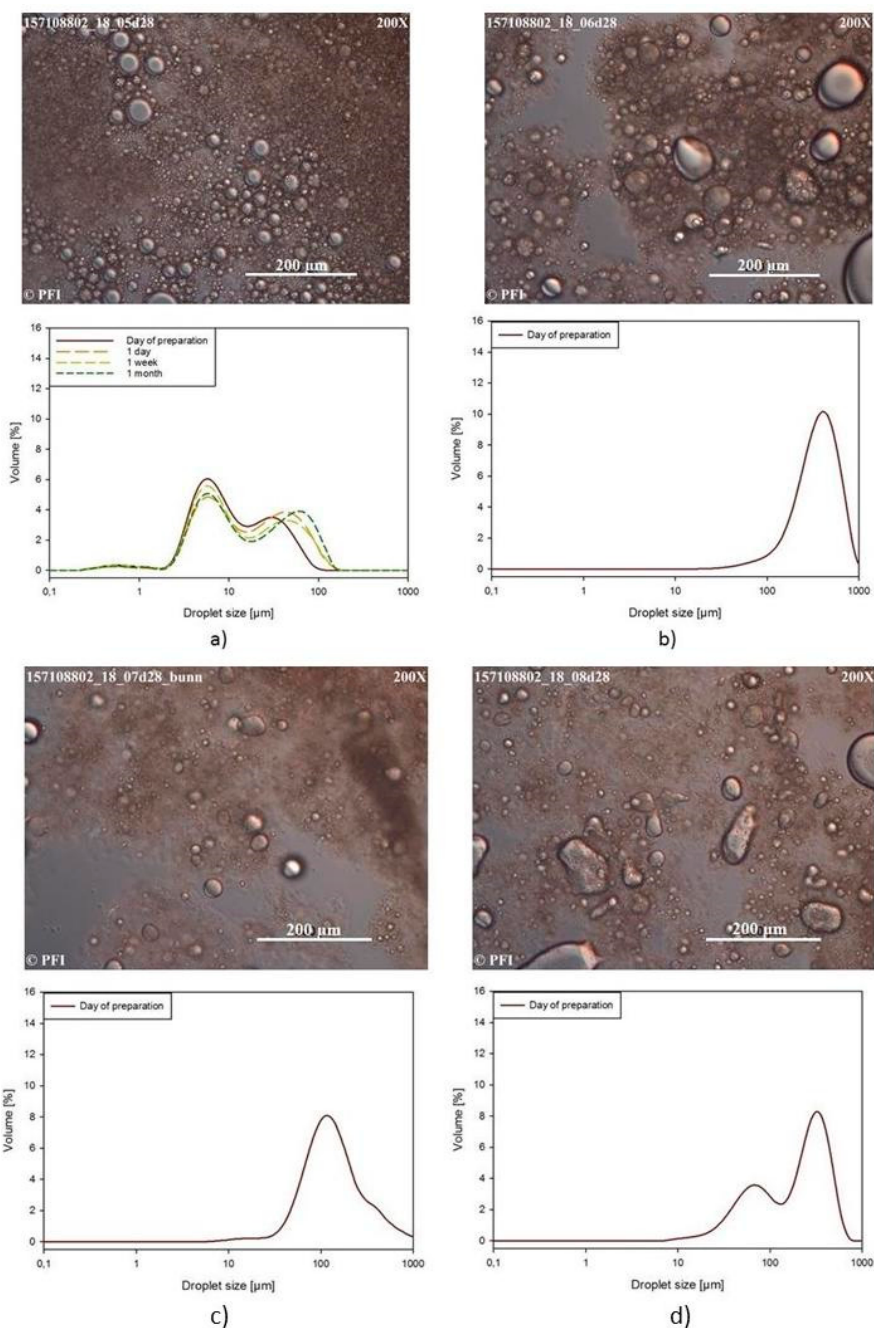
Figure 4. Light microscopy images taken after one month of storage, as well as the droplet size distributions over time for emulsions stabilized with 0.5 wt % CNF-T, for ( a ) a reference emulsion, ( b ) an emulsion with 0.2 wt % acetic acid, ( c ) an emulsion with 1.0 wt % NaCl and ( d ) an emulsion with 0.2 wt % acetic acid and 1.0 wt % NaCl.